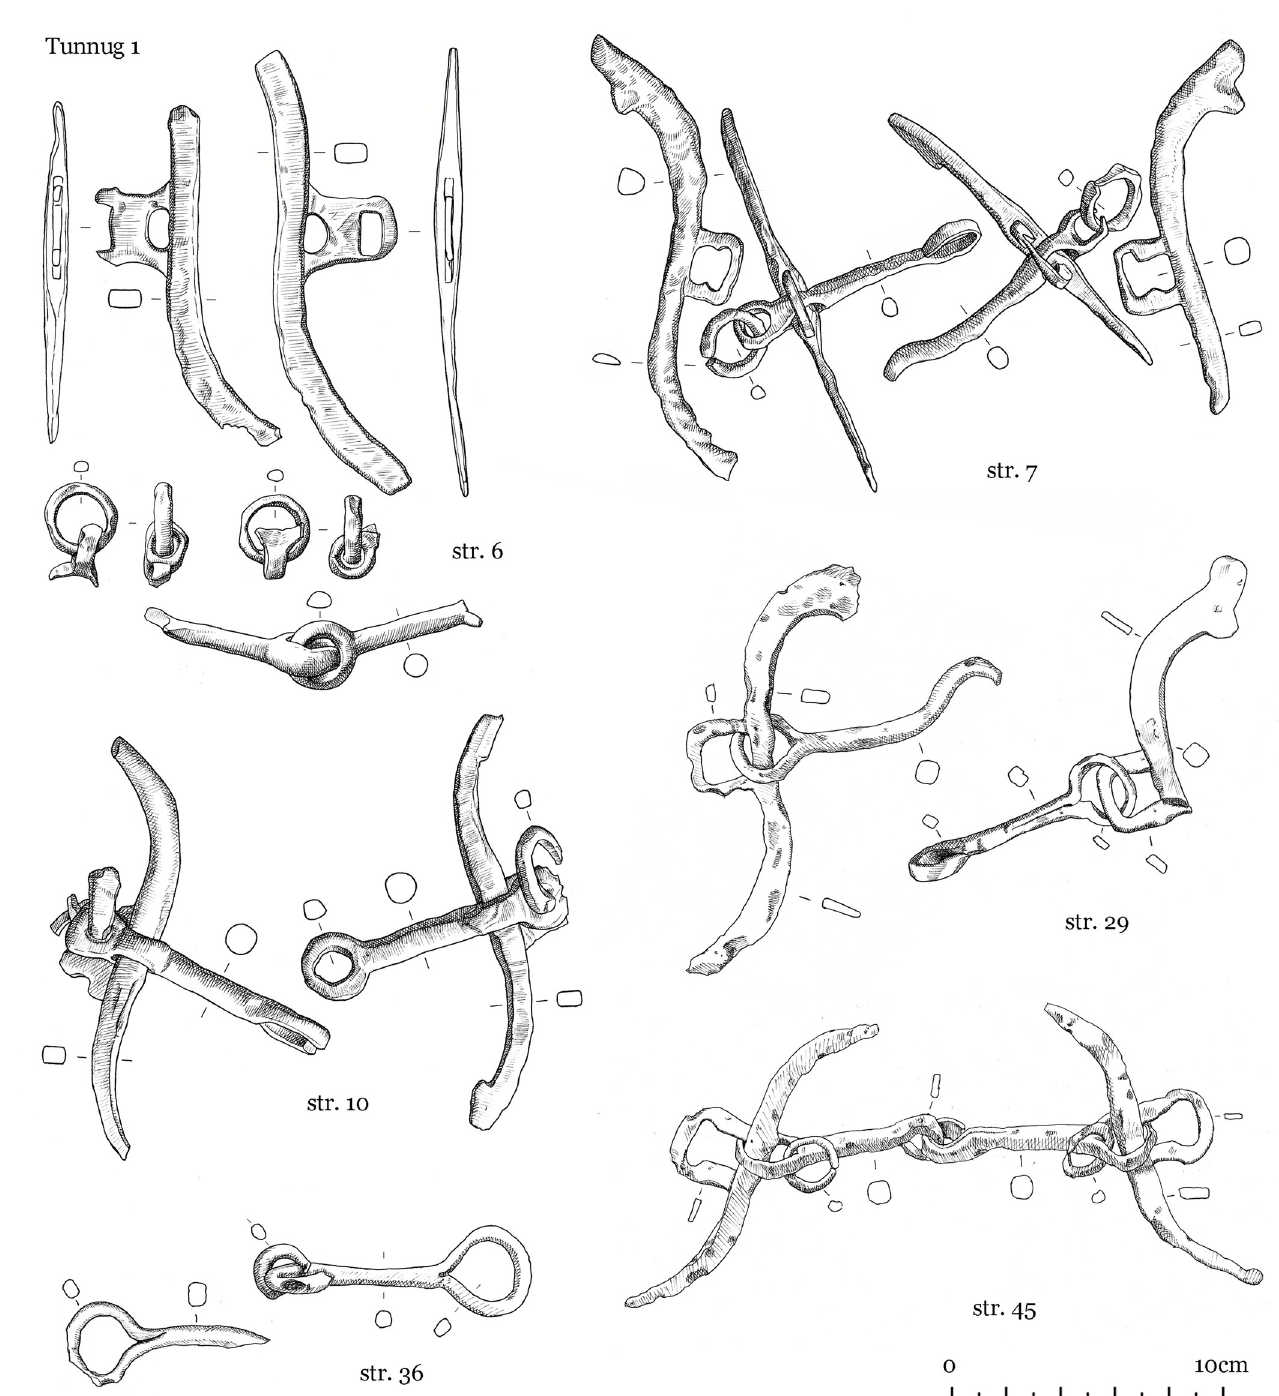
Fig 4. Tunnug 1. Medieval artifacts. Iron horse bits.